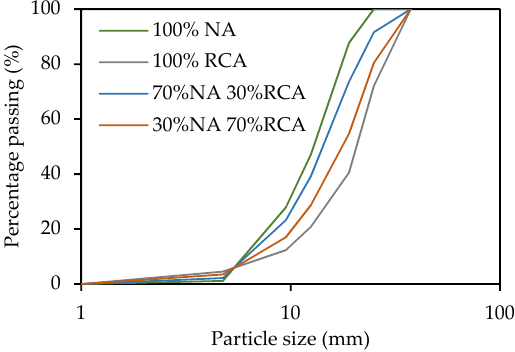
Table 2. Physical properties of fine and coarse aggregates.